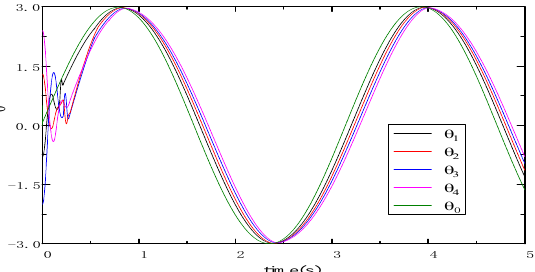
Figure 14. Compared with the consensus tracking protocol proposed in the reference [22], all motor tracking curves under the same simulation conditions: position signals of all